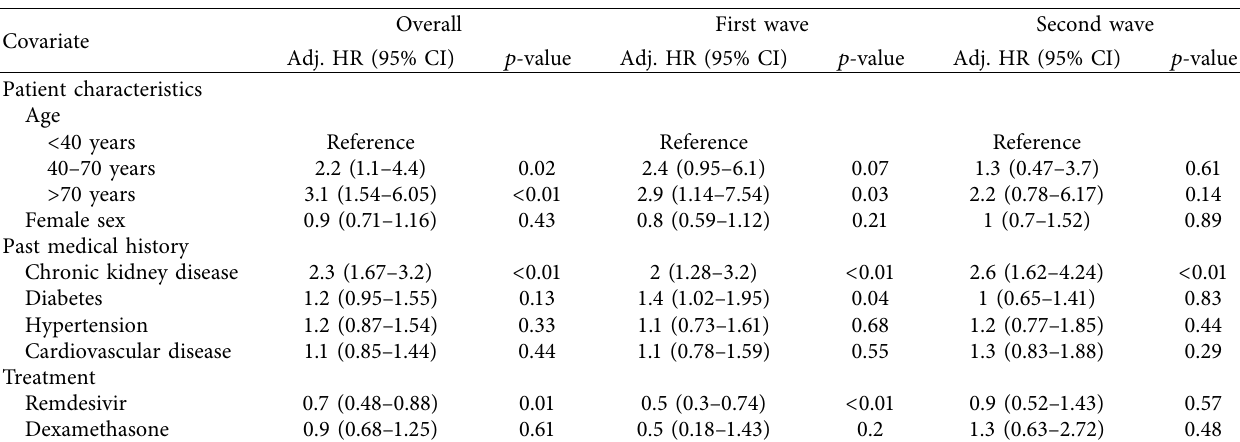
Table 4: Comparison of risk factors for AKI.